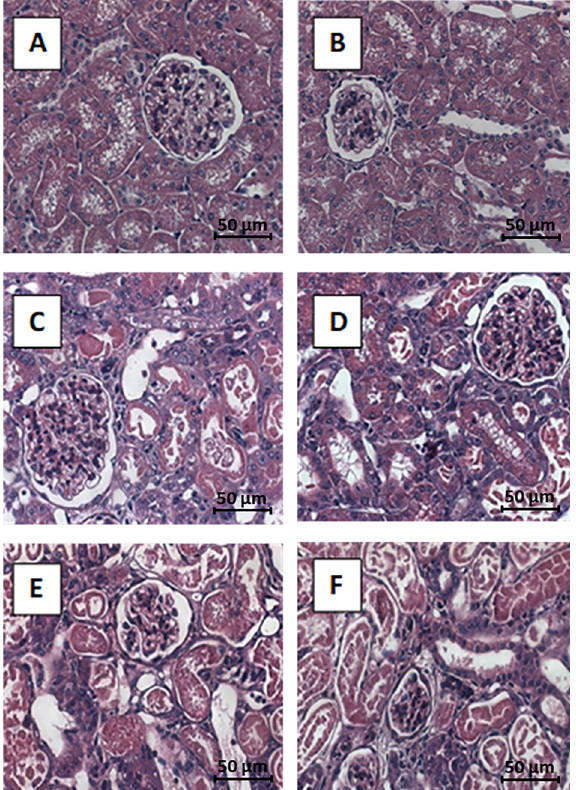
Figure 1. Effect of n-acetylcysteine (NAC) on renal ischemia reperfusion (I/R) injury. Sham ( A ) and SHAM + NAC ( B ) kidneys presented normal histology. Ischemia (ISC) 30 min ( C ), ISC 30 + NAC ( D ), ISC 45 min ( E ), and ISC 45 + NAC ( F ) displayed tubulointerstitial damage as de fi ned by tubular necrosis, in fl am- matory cell in fi ltration, tubular lumen dilatation, or tubular atrophy. HE staining (scale bar 50 m m).